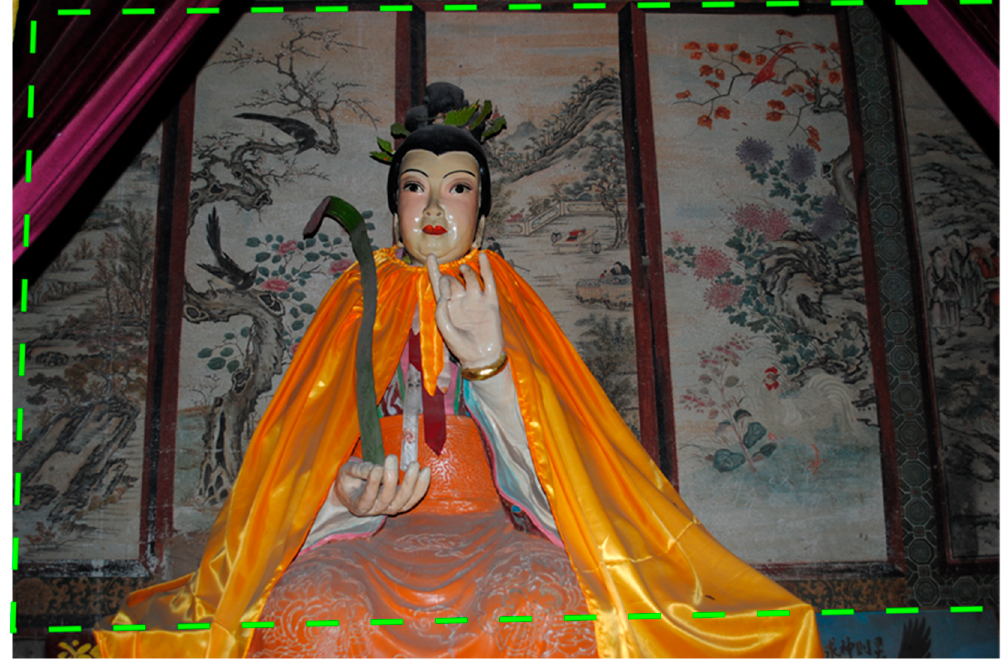
Figure 8. A folding screen depicting human figures, mountains and rivers, and flower and bird in the Yandi Temple in Jiaohe Village, Hexi Town (No. 60 in Figure